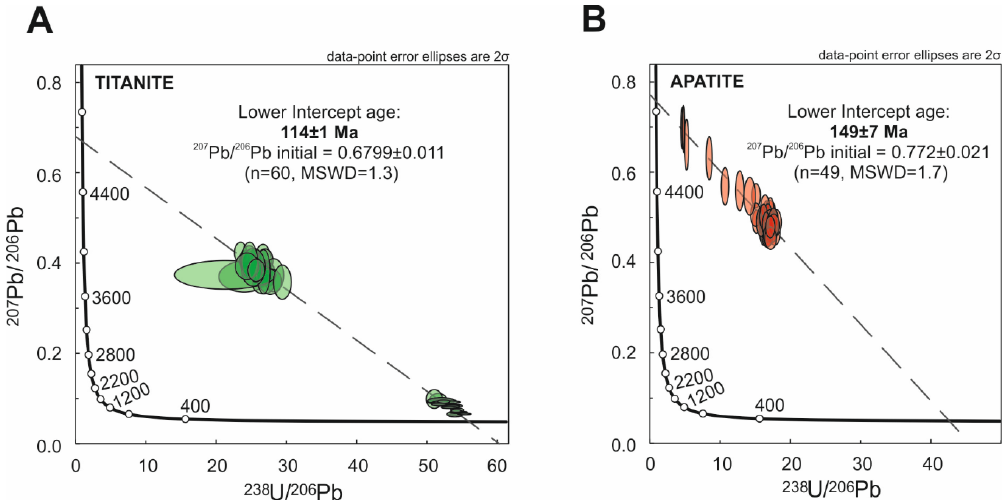
Figure 4. Tera–Wasserburg concordia plots for LA–ICP-MS U–Pb titanite ( A ) and apatite ( B ) analyses from the Kanarata quarry. Data-point error ellipses are 2 σ